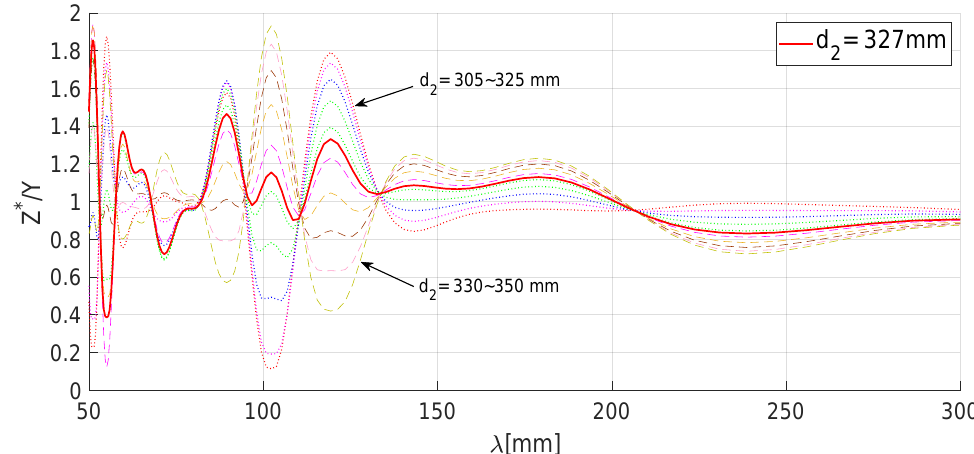
Figure 13. Optimal point algorithmic